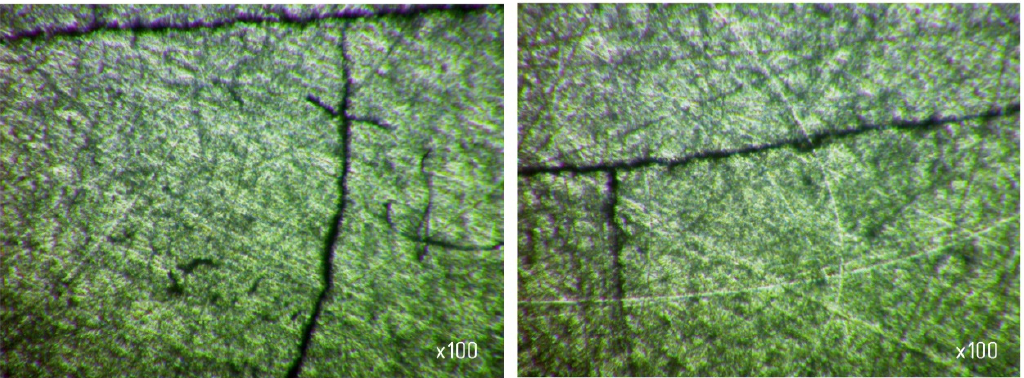
Figure 17. Cracks and gouges on the treated surface after lapping with a pressure of 337 kPa (3.4 kg/cm 2 ) (magnification ×100).